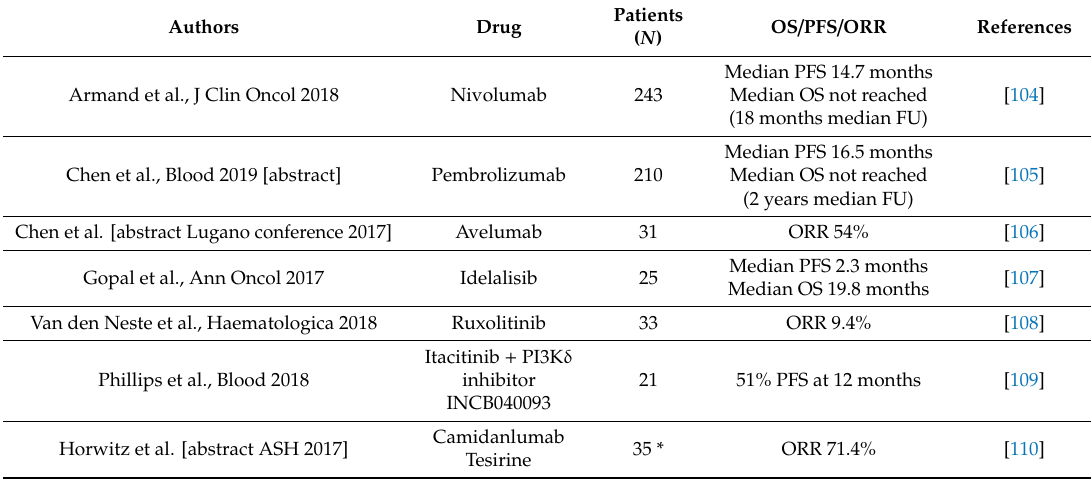
Table 1. E ffi cacy of novel agents for the treatment of relapsed / refractory